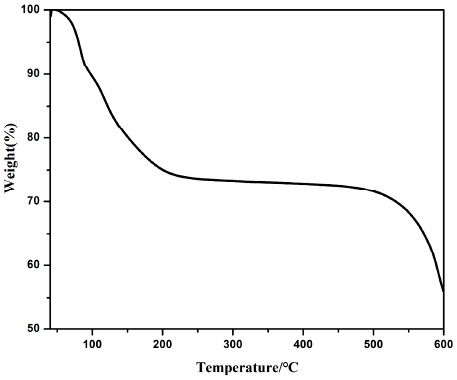
Figure 5. Thermogravimetric analysis (TGA) curves for the complex 1 .